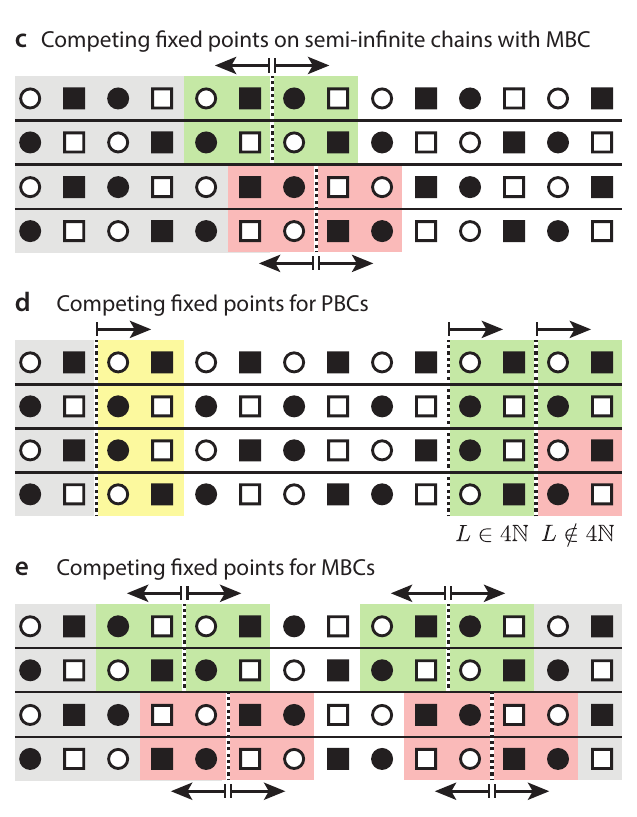
Figure 13: Fixed points. a The homogeneous fixed points are always present and the only stable ones (due to the eroder property). Competing (unstable) fixed points are possible but depend on the boundary conditions: b Infinite chain (4 additional fixed points). c Semi-infinite chain with mirrored boundary condition (2 additional fixed points if the first cell is even, none otherwise). d Periodic boundary conditions (4 additional fixed points if L is a multiple of 4, 2 otherwise) e Mirrored boundary conditions (2 additional fixed points if the first cell is even and the last is odd, none